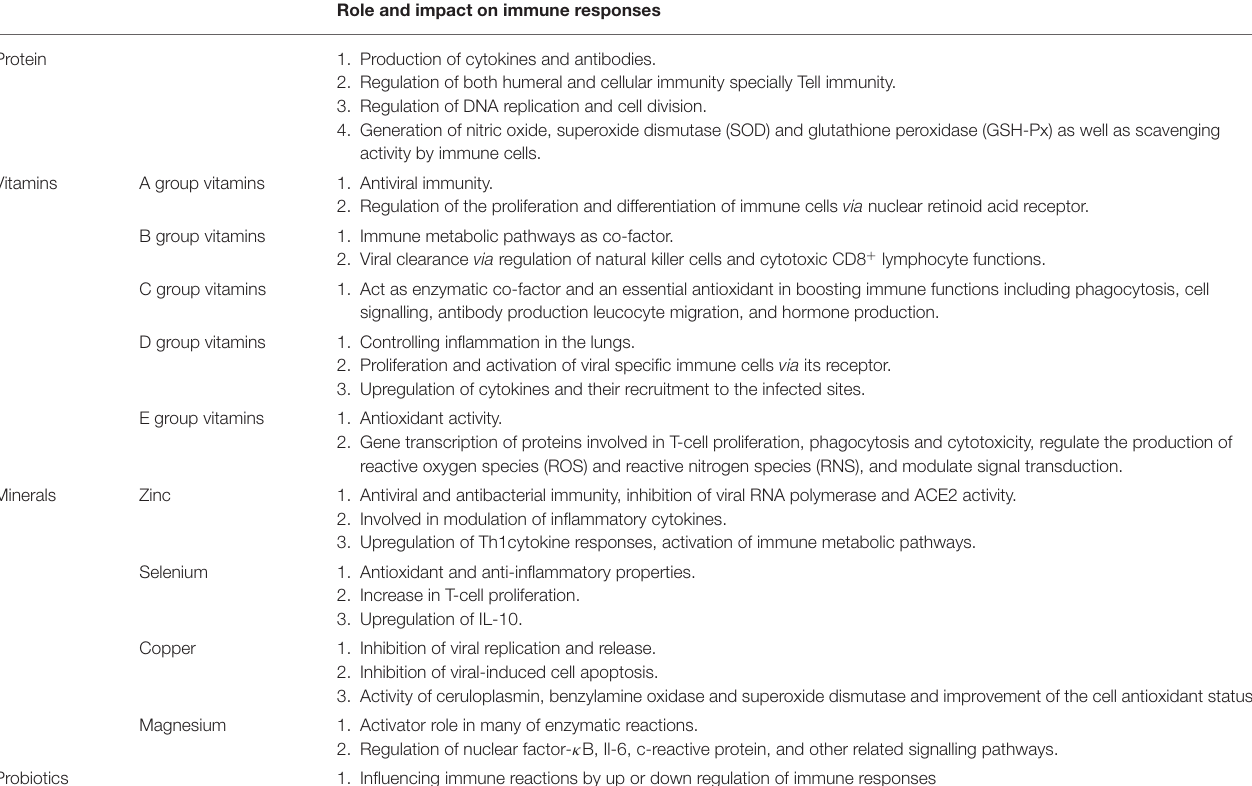
TABLE 1 | Overall role and impact of nutrition on immune